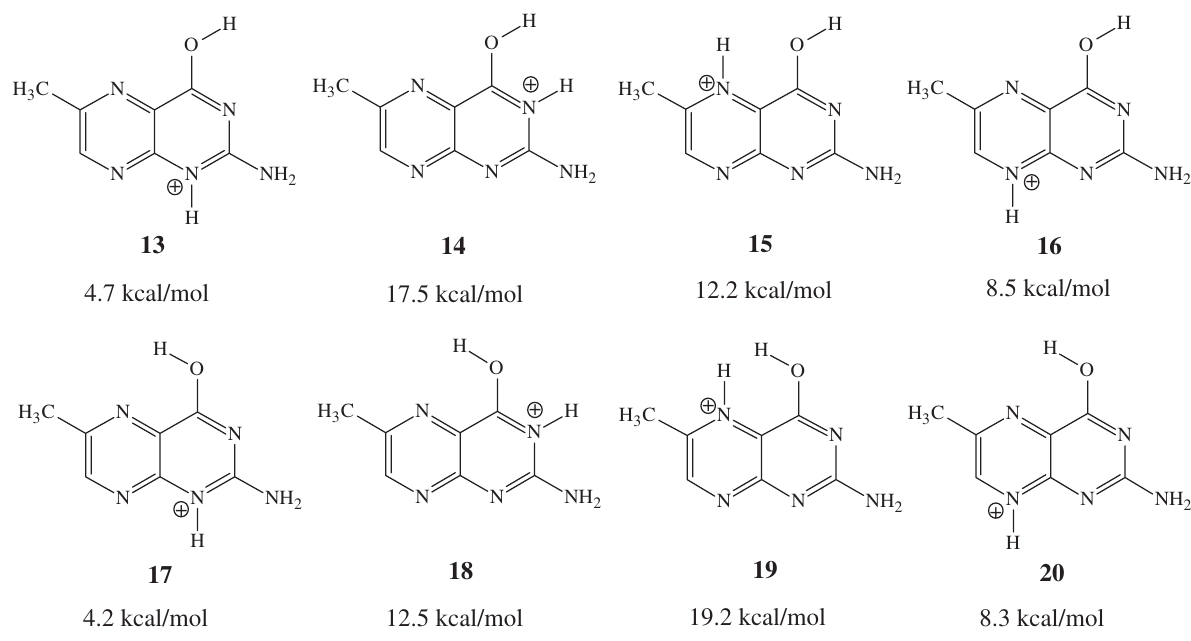
Figure 5 Relative calculated energies of pterins resulting from the ring nitrogen protonation of the two lactim structures, 2 (top) and 3 (bottom).